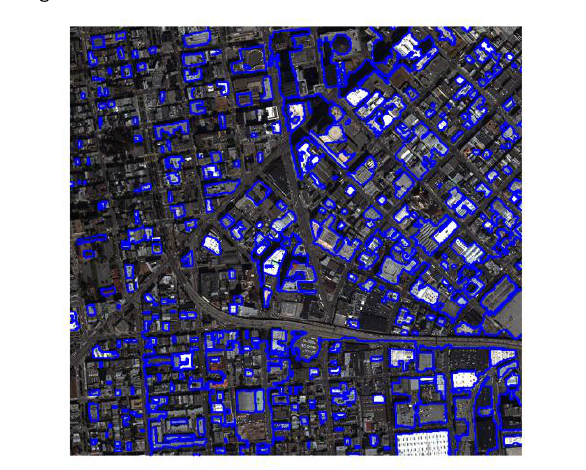
Figure 3. The resultant building detection in a WorldView2